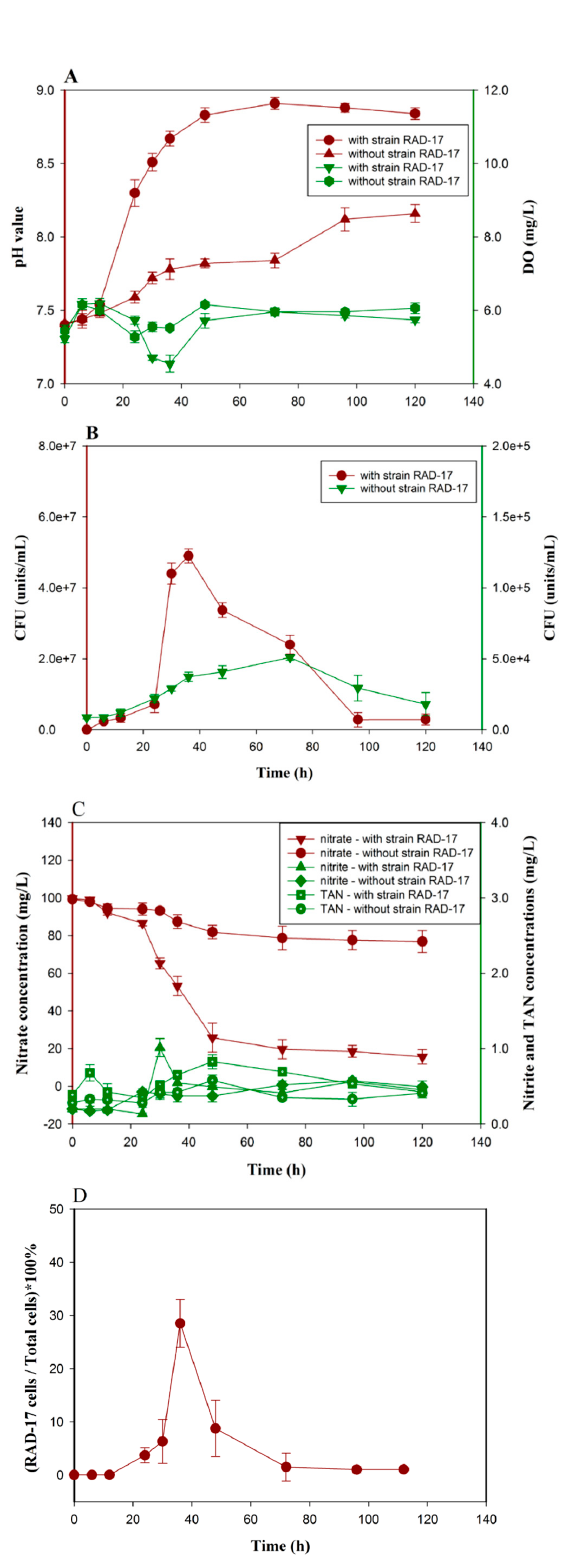
Figure 5. The bioaugmentation performance of the RAD-17 strain in actual recirculating aquaculture system (RAS) effluent. ( A ) pH and DO values; ( B ) maximum potential denitrifying strains numbers; ( C ) inorganic nitrogen concentrations; ( D ) strain RAD-17 abundance. Data shown are means ± SD (error bars) from three